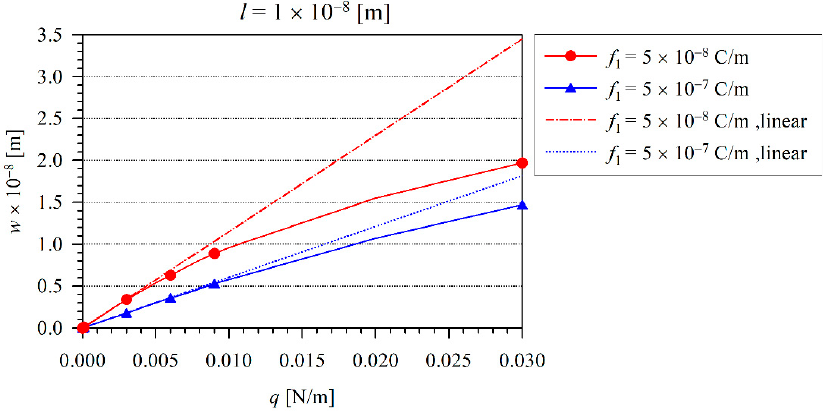
Figure 4. The variation of maximal beam deflection w with the load q for various flexoelectric coefficients and at the microstructural length-scale parameter l = 1 × 10 − 8 m.